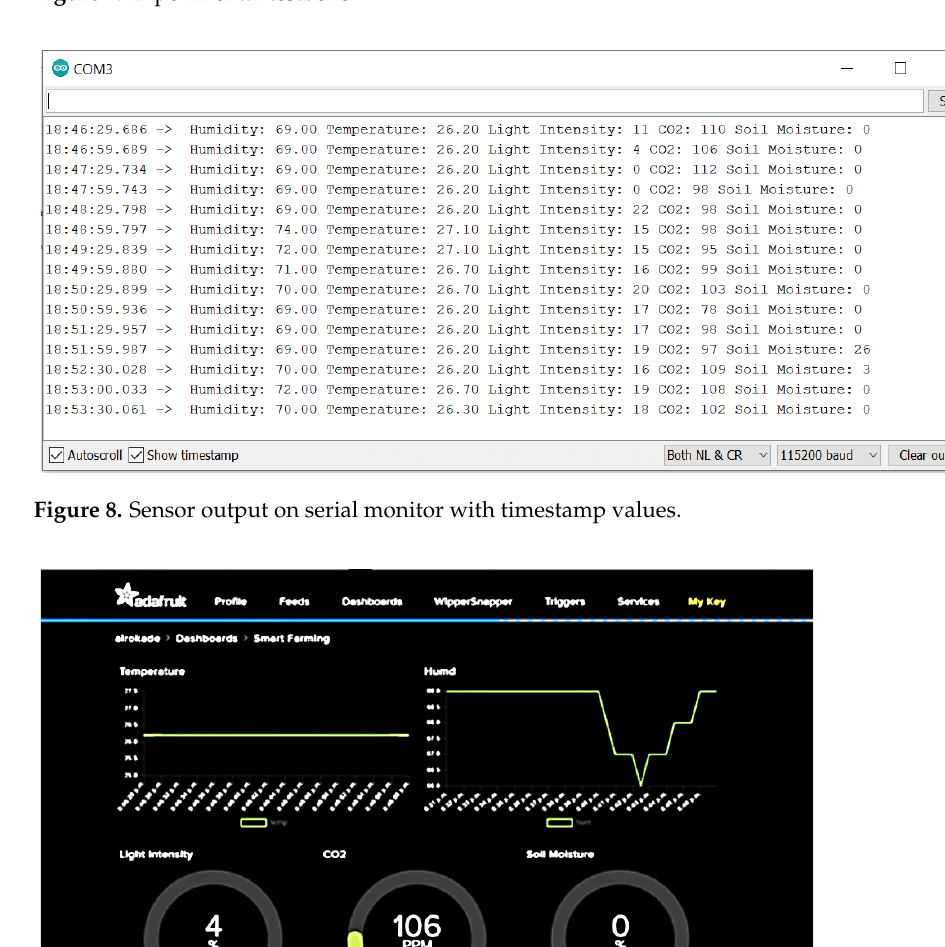
Figure 10. Sensor output on Adafruit IO Cloud IoT dashboard for Case 2.